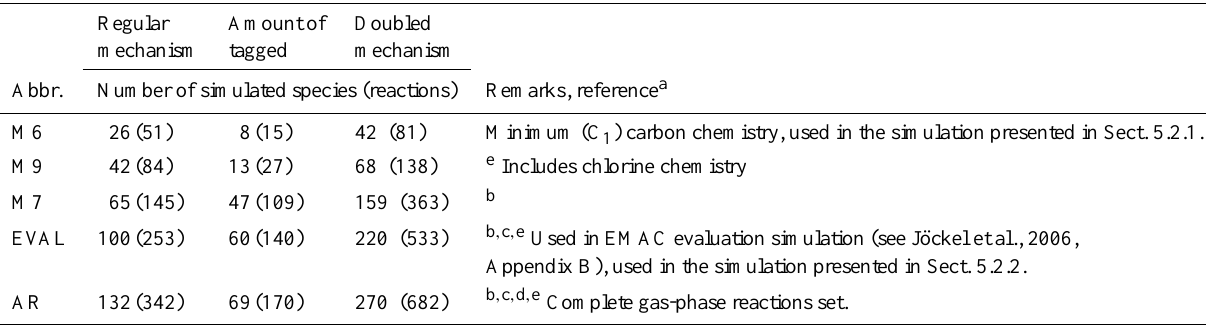
Table 3 . Comparison of selected MECCA mechanisms. Regular Amount of Doubled mechanism tagged mechanism Abbr. Number of simulated species (reactions) Remarks, reference